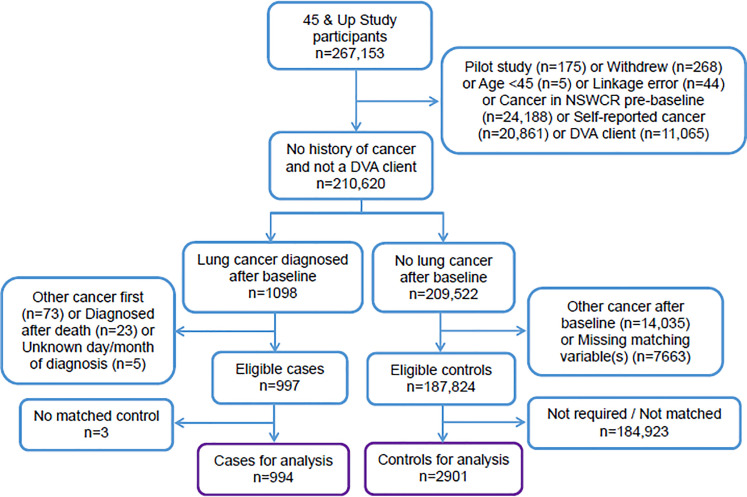
Cohort selection flow diagram.DVA: Department of Veterans’ Affairs; NSWCR: New South Wales Cancer Registry.